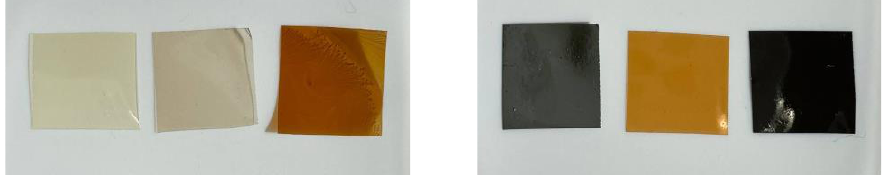
Figure 1. Images of self-standing polymer films of different compositions. From left to right: F1, F2, F1Ag, F2Ag, F3, F3Ag.